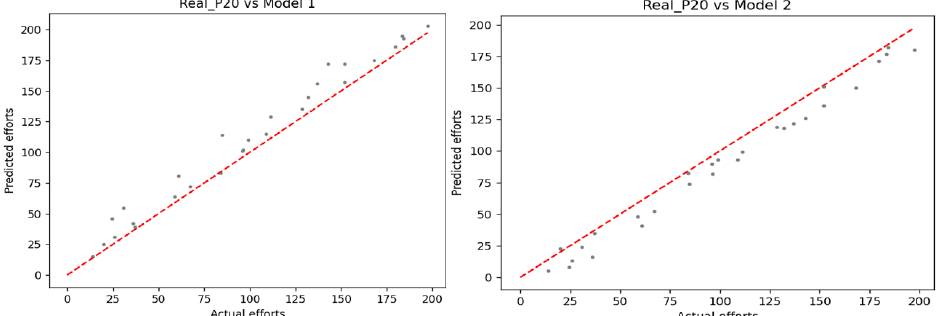
Figure 2. The scatter of predictive efforts vs. actual efforts: Model 1 vs. 2.